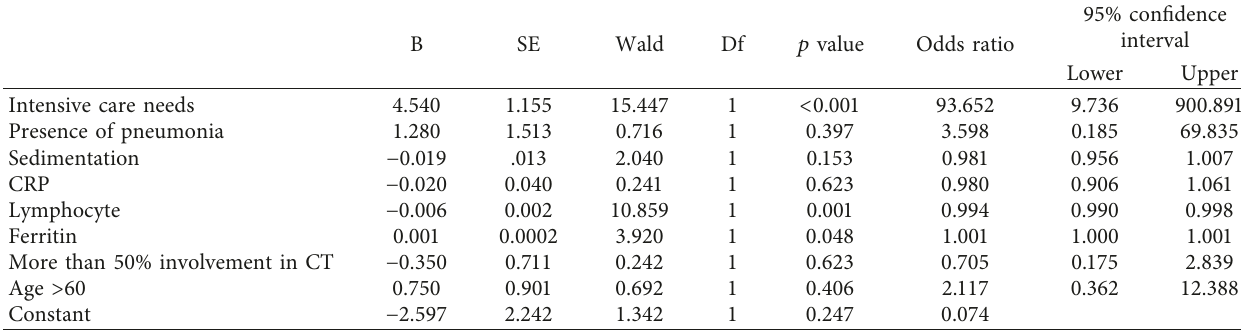
Table 4: Analysis of factors affecting mortality.